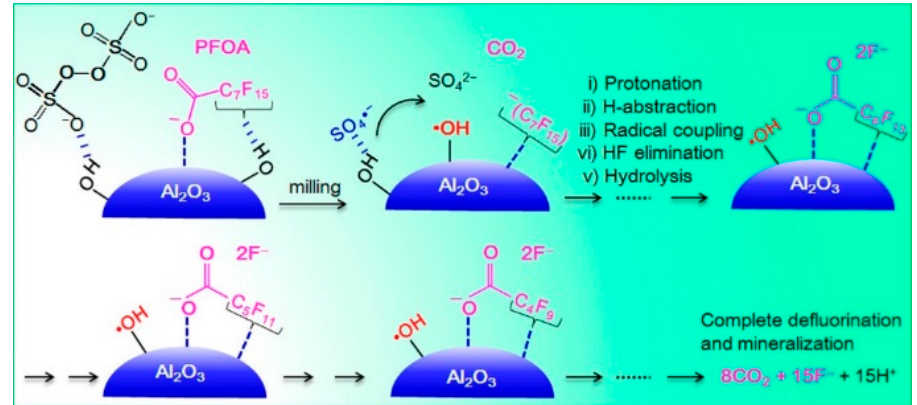
Figure 6. Proposed representation of synergetic influences of sodium persulfate (PS) and alumina during mechanochemical activation of PFOA (reprinted with permission from [127], copyright 2019 American Chemical Society).